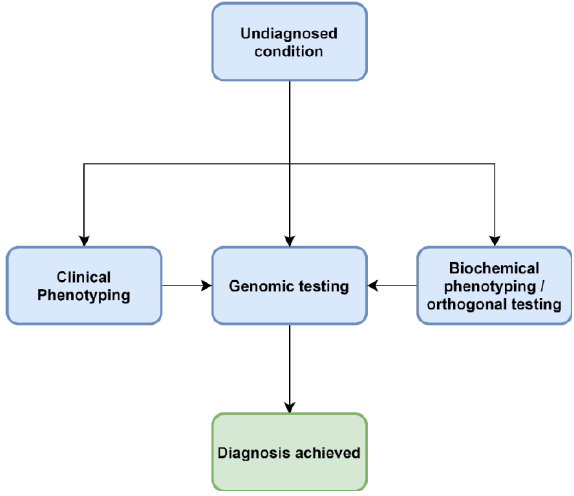
Figure 3. A future approach to diagnoses of IEM.